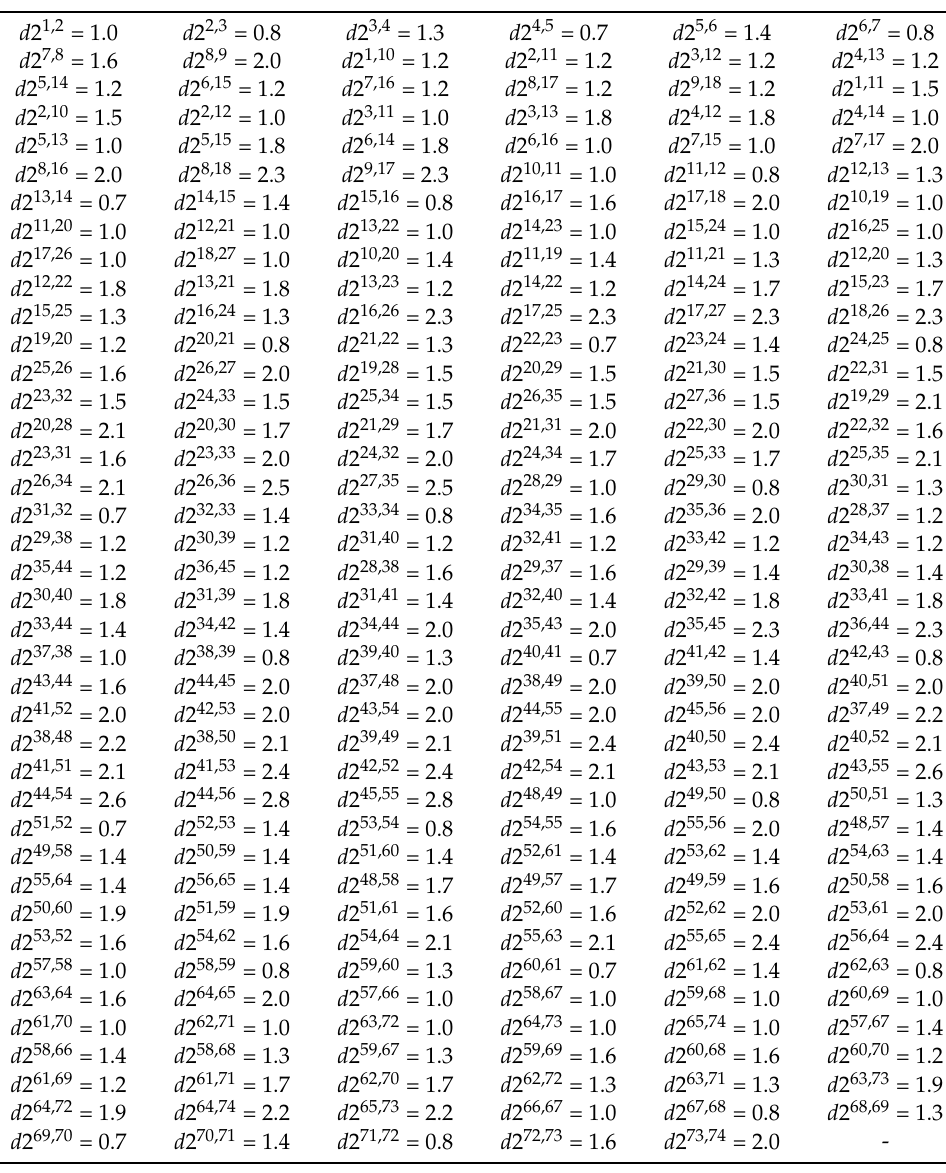
Table 7. Distances between intersections